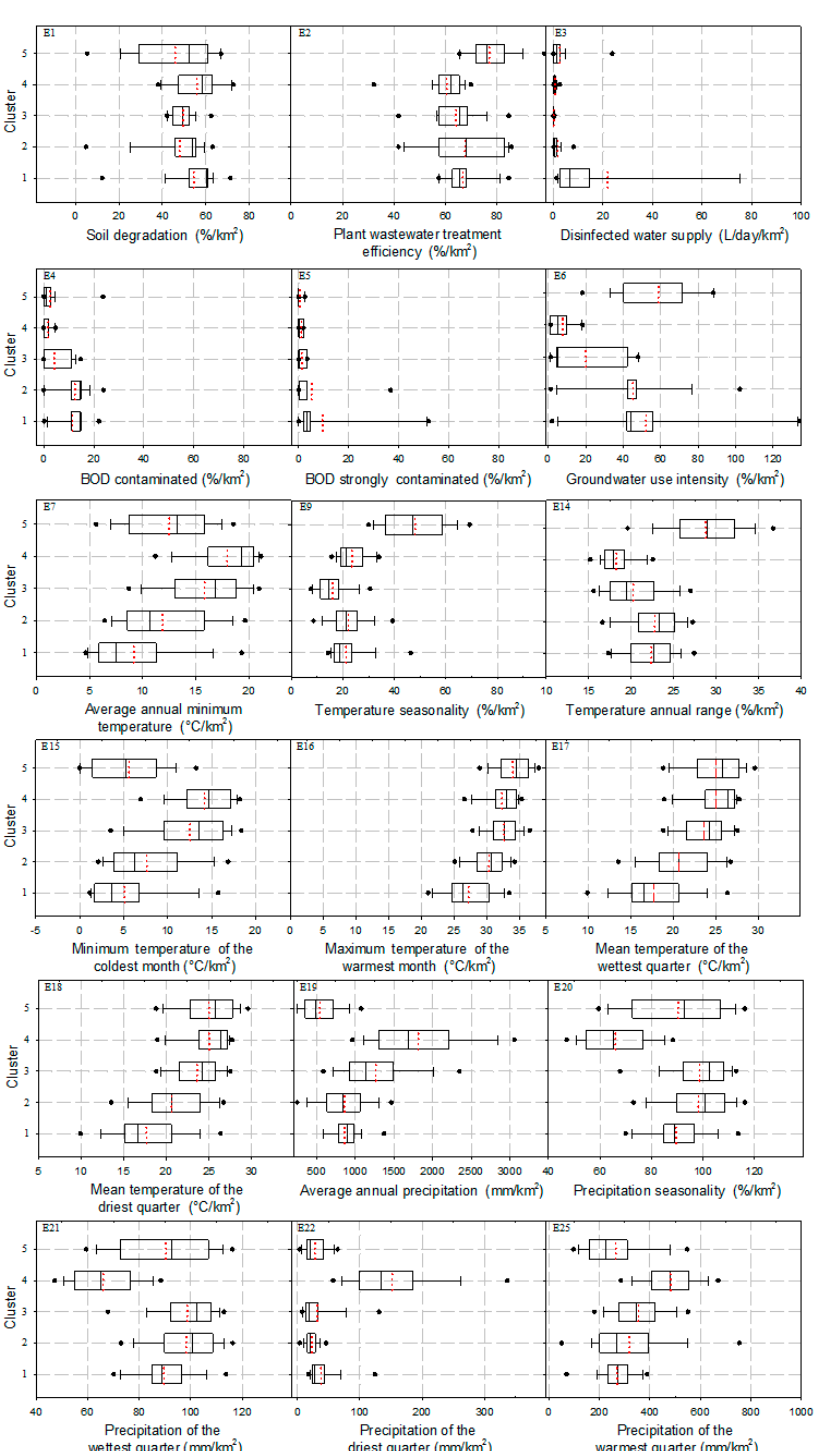
Figure 6. Regional environmental characteristics with real values. Average value is the dotted red line.